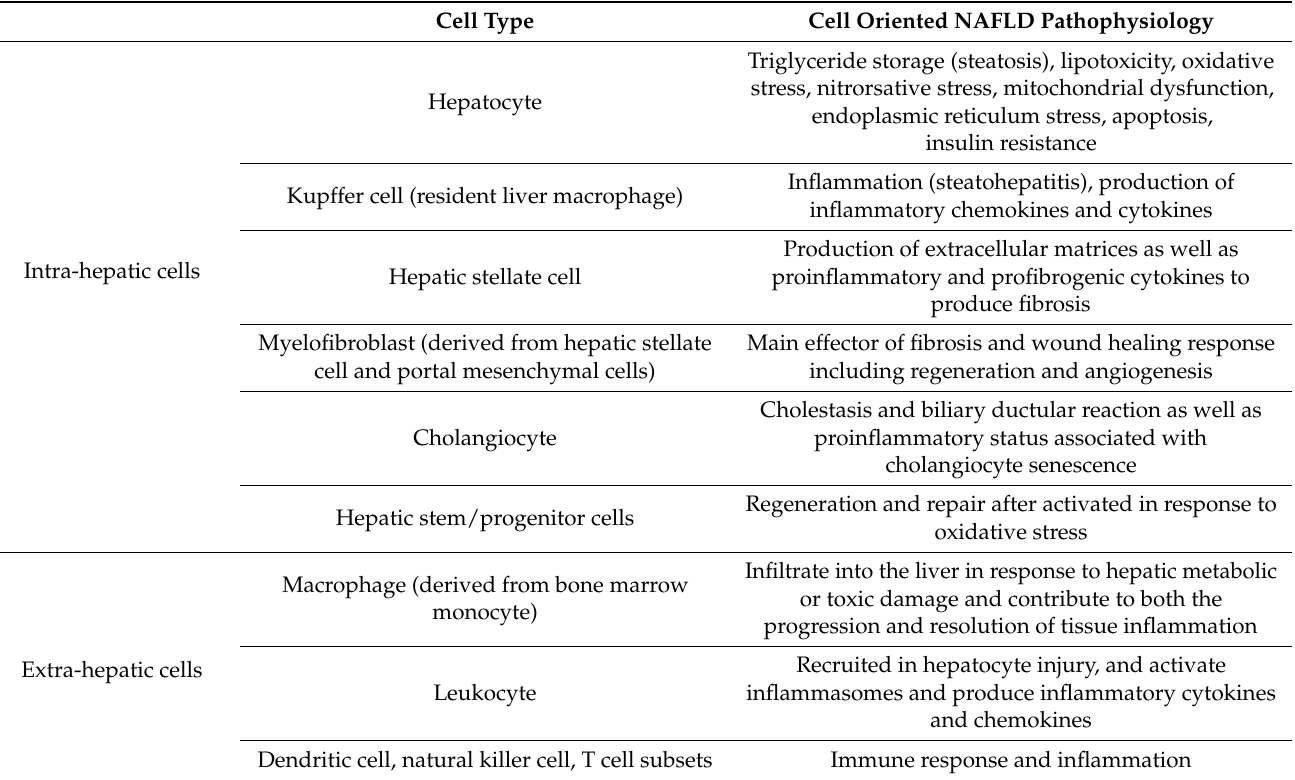
Table 1. Pathophysiologic mechanisms of NAFLD focused on the functions of individual hepatic cells.